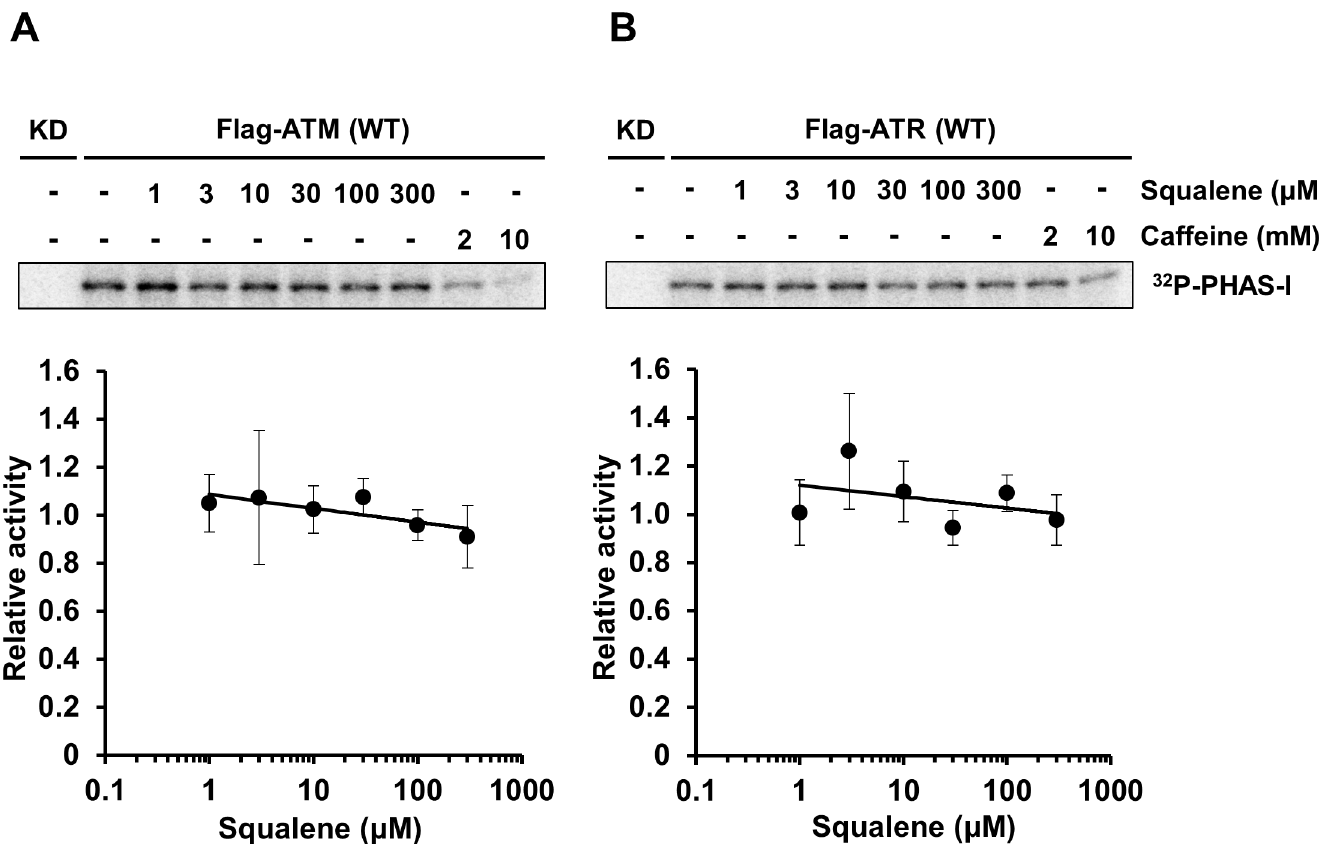
Fig 5. Squalene does not inhibit ATM and ATR kinases. ATM (A) and ATR (B) kinase activities were measured in vitro using PHAS-I as the substrate in the presence of squalene (1, 3, 10, 30, 100, and 300 μ M). HEK293T cells were transfected with flag-tagged ATM- or ATR-wt plasmid. ATM and ATR protein kinases were purified by immunoprecipitation using anti-Flag 1 M2 antibody and protein-G sepharose. Kinase activity was monitored for 20 min at 30°C. Data are presented as the mean ± S.D. of three independent experiments. Caffeine (2 and 10 mM) was used as an ATM/ATR inhibitor.